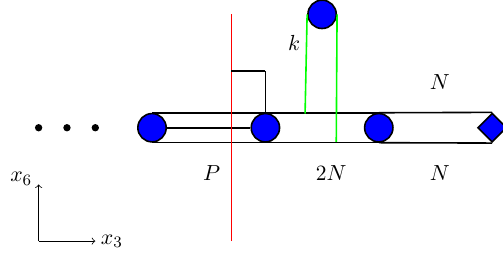
Figure 57 . Type IIB configuration corresponding to a vortex defect for the U(2 N ) gauge group in the generic D -type quiver discussed above. The green vertical lines denote k respectively, where k + . . . + k = k . The configuration corresponds to a vortex defect in a 1 N representation R = S of U(2 N ) k